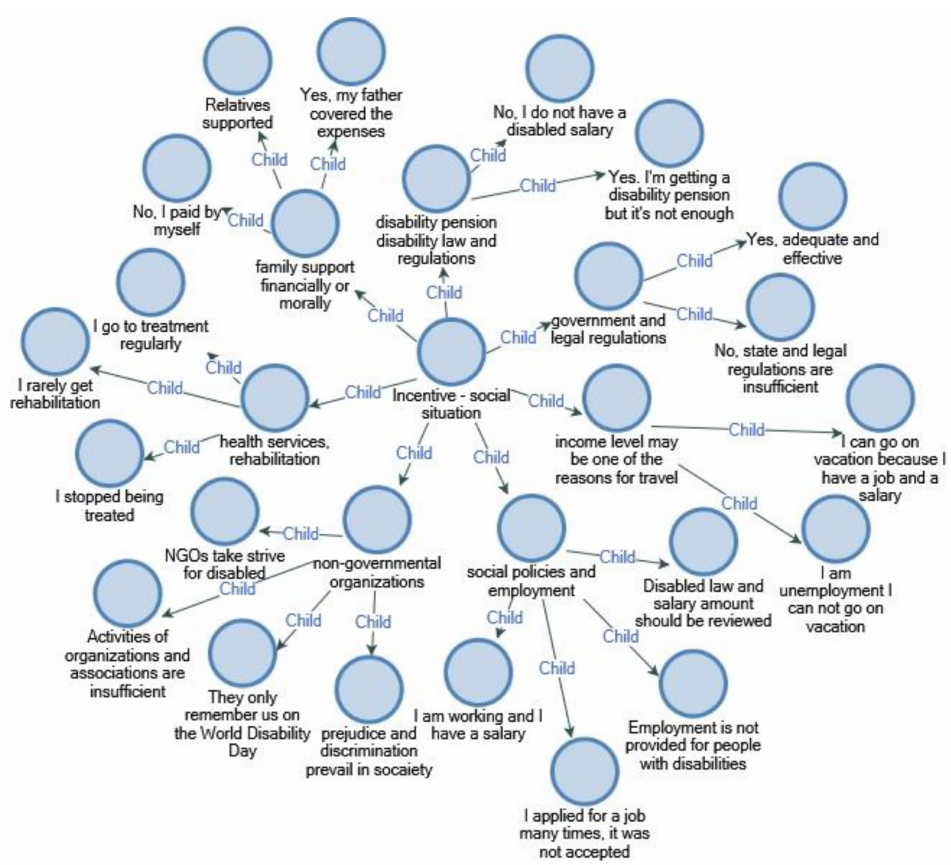
Figure 4. Social status and